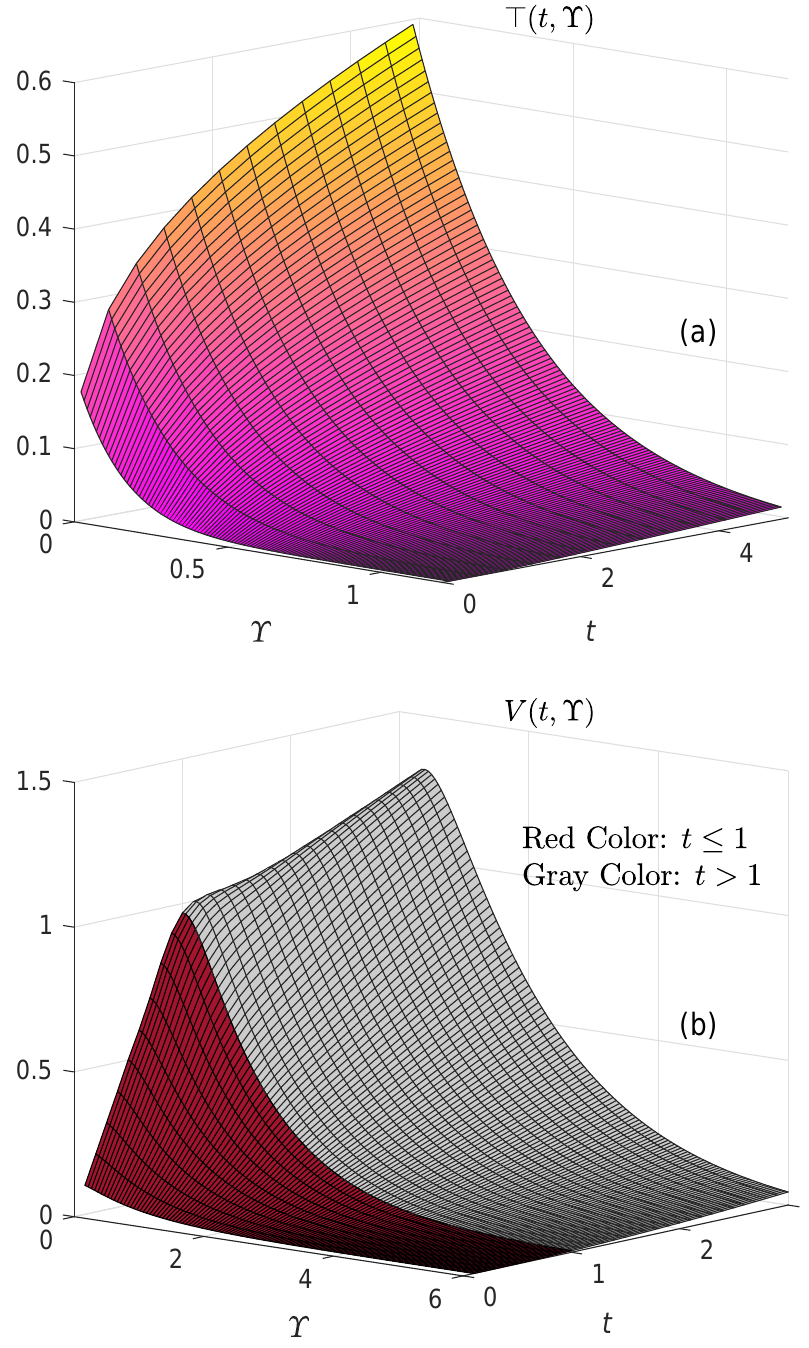
Figure 4. ( a ) Three-dimensional illustration of thermal profile. ( b ) Three-dimensional illustration of flow